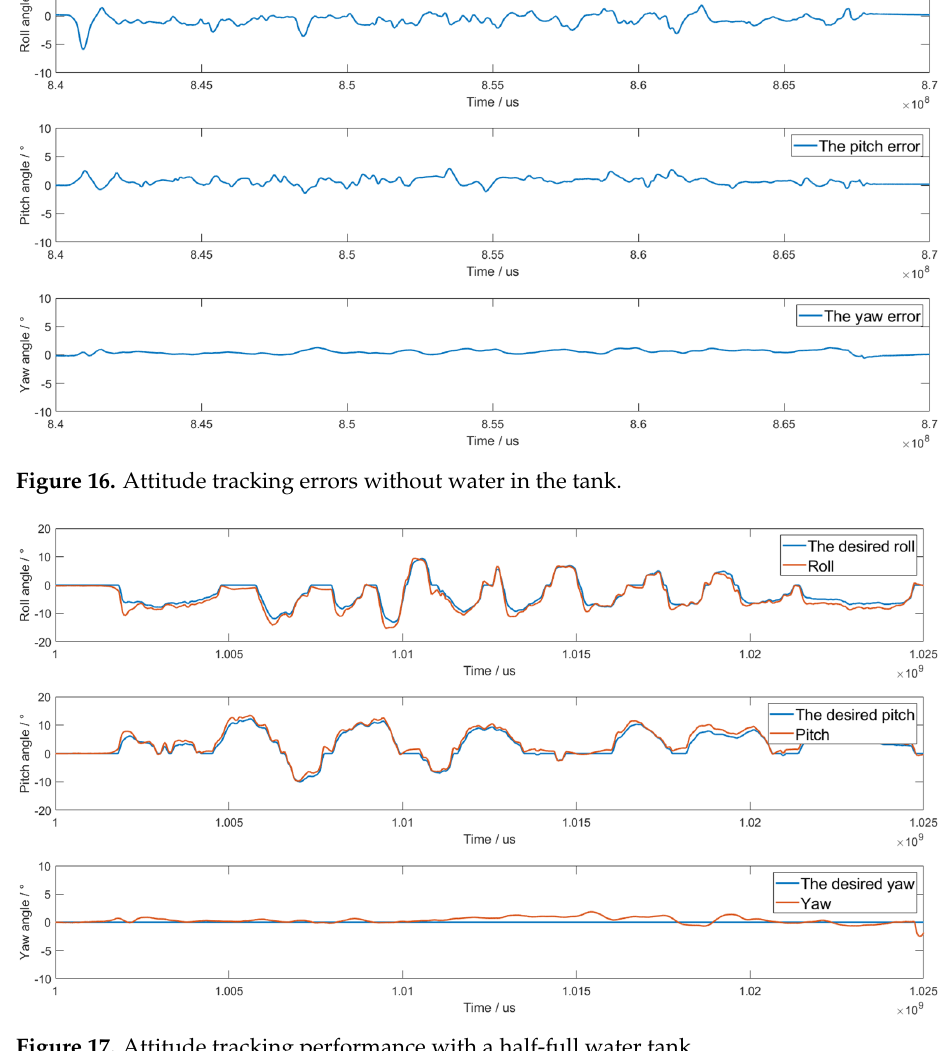
Figure 17. Attitude tracking performance with a half-full water tank.